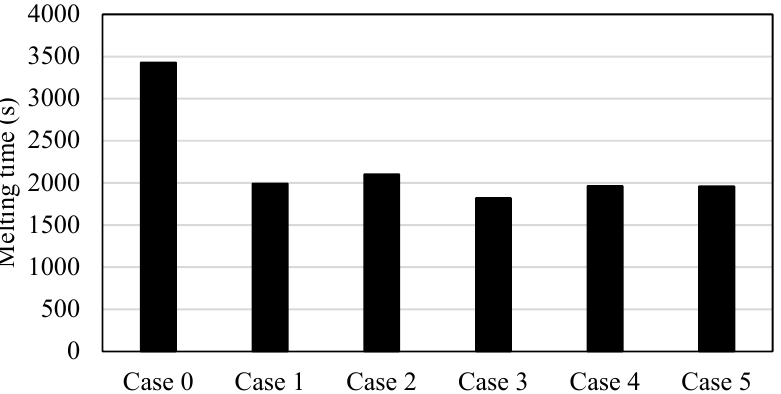
Figure 9. Melting time until reaching 95% of the capacity for the finless case and the cases of different orientations of fins directions.